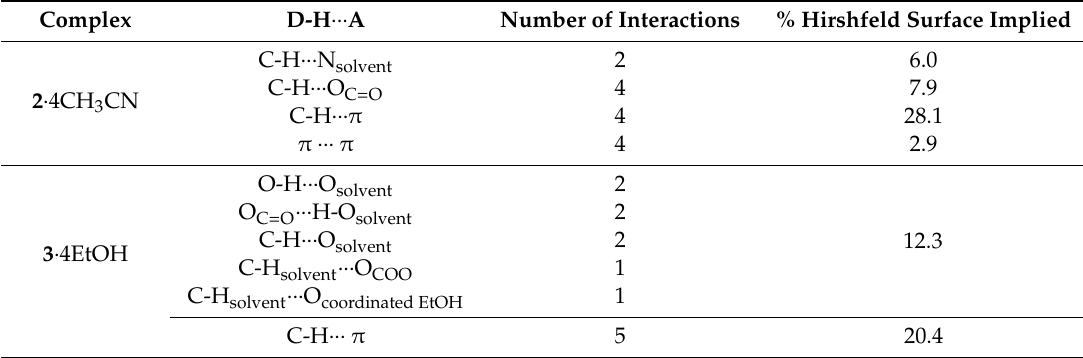
Table 4. Comparison of the supramolecular interactions of compounds 2 · 4CH 3 CN and 3 · 4EtOH.